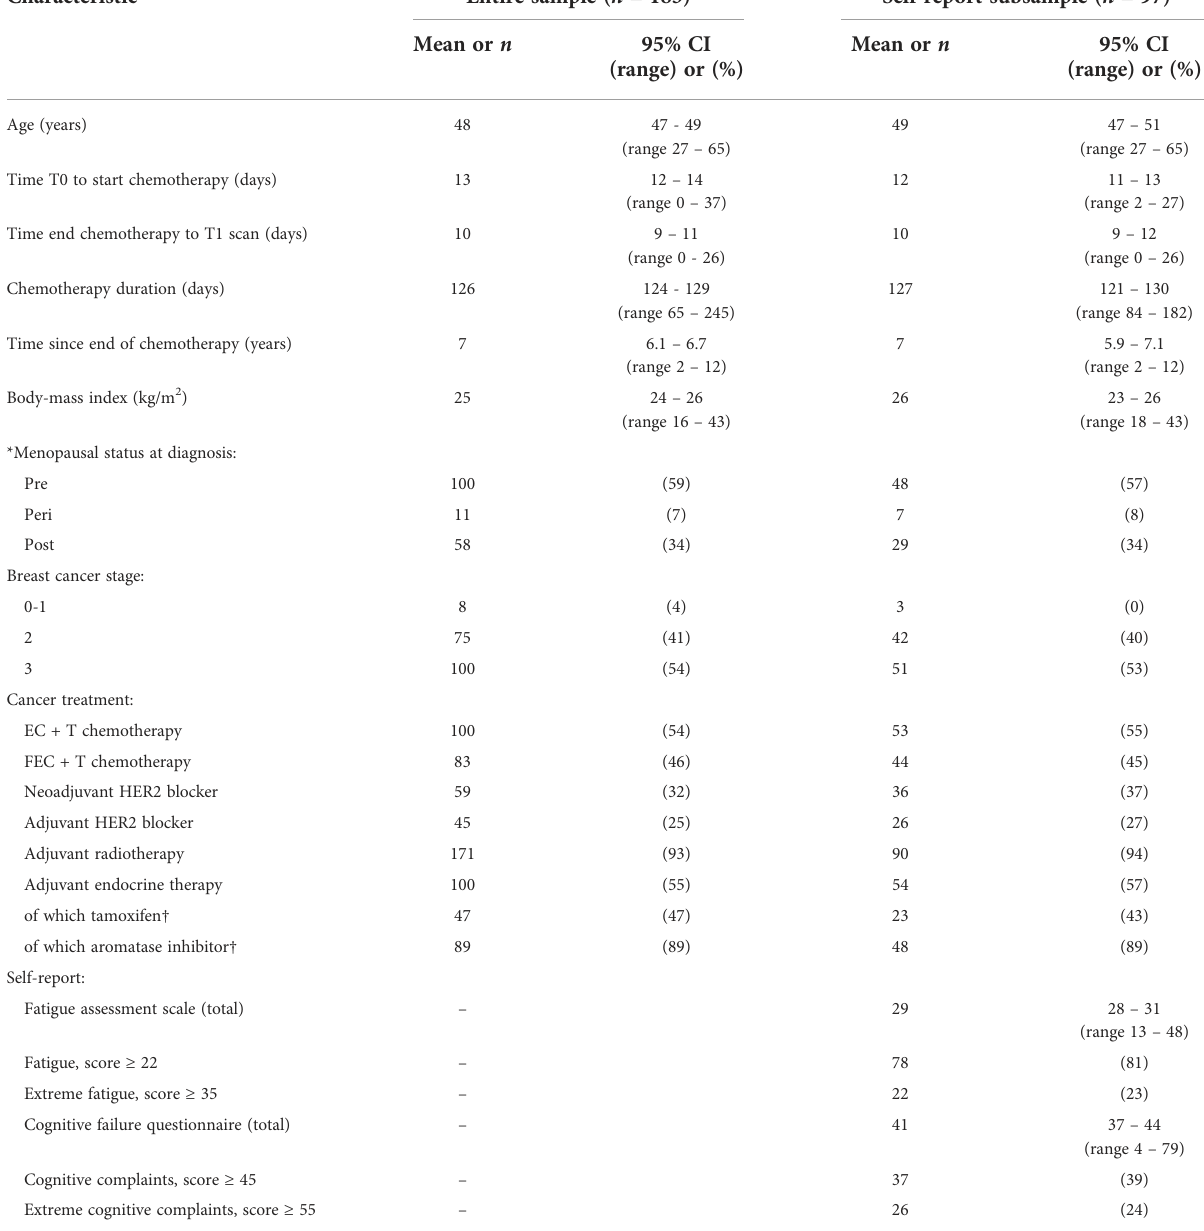
TABLE 1 Demographics and characteristics of the study